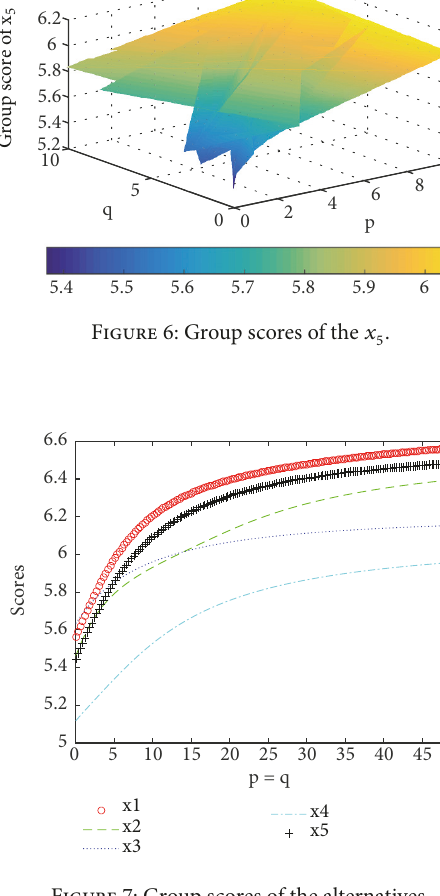
Figure 7: Group scores of the